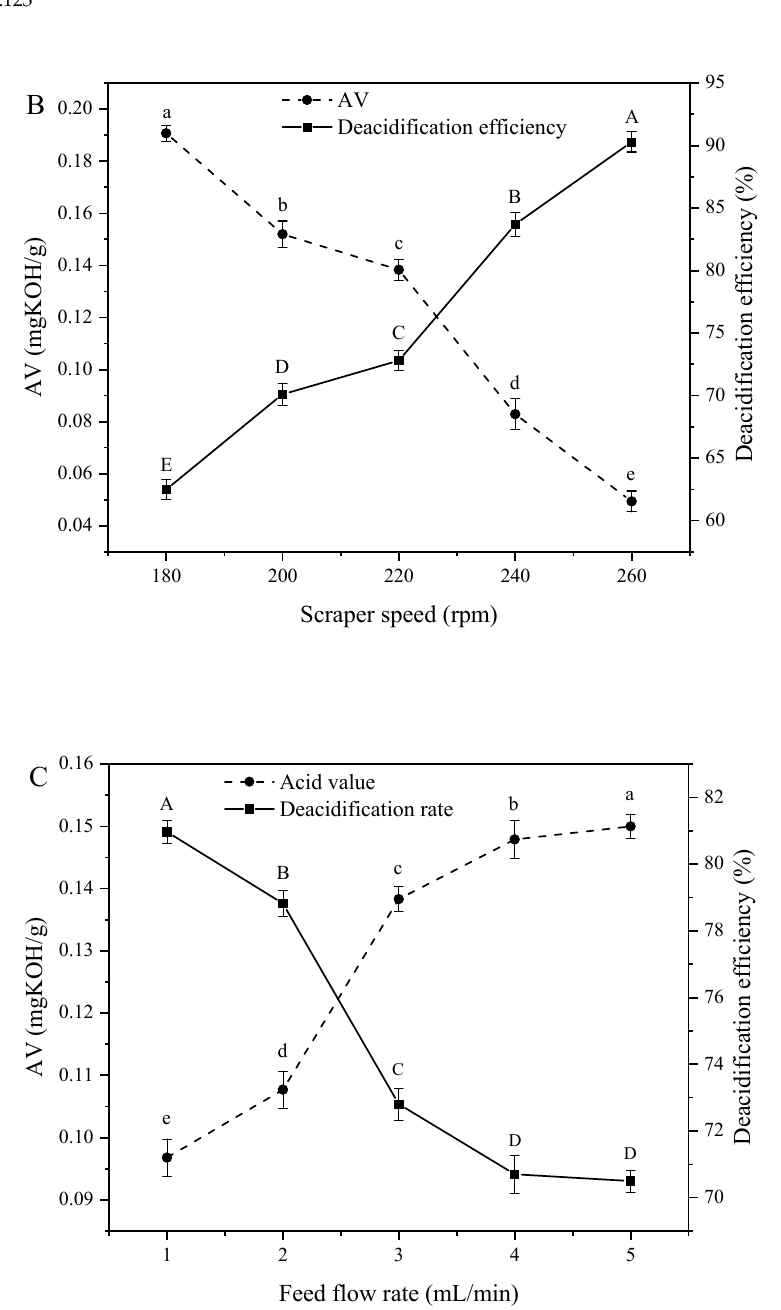
Figure 1. Effect of ( A ) evaporation temperature, ( B ) scraper speed, and ( C ) feed flow rate on the acid value (AV) and deacidification efficiency of soybean